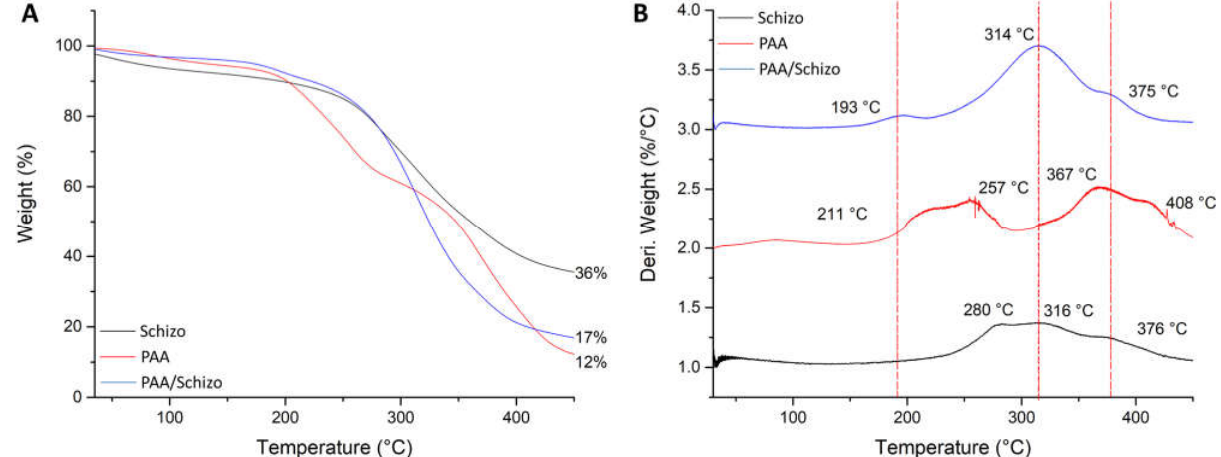
Figure 5. Thermogravimetric analysis ( A ) and derivative thermogravimetric (DTG) curves ( B ) of PAA, Schizochytrium sp. biomass and PAA/Schizo microgels. Thermal decomposition of the samples was carried out from 30 to 450 °C with a heating range of 10 °C/min under nitrogen gas flow.